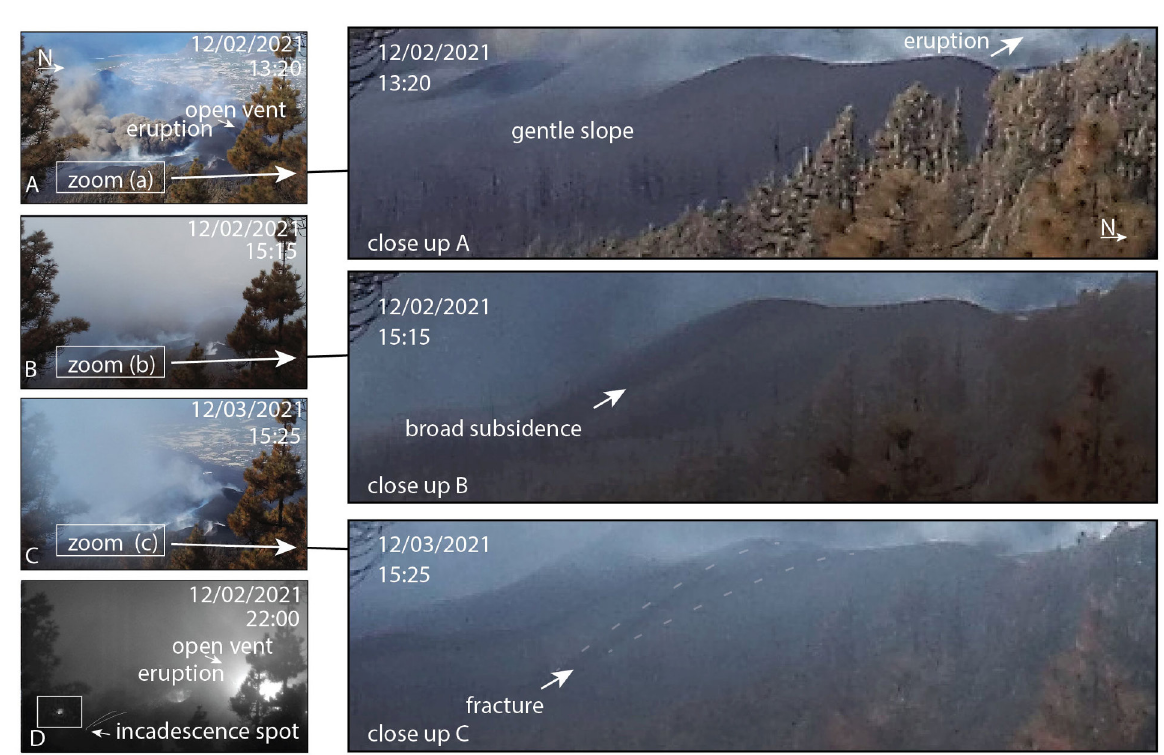
Figure 3: Camera records, realised by fixed installed time-lapse trail Cam-4 (for location, see Cam-4 in Figure 1B). The selected images allow us to determine approximate timing and evolution of the fracture. [A] View onto the eruption crater, also visible is the steaming of the new open vent to the right. Close up shows gentle slope. [B] Limited visibility, but close up (right column) onto the gentle southern slope illustrates the emergence of a broad subsidence region. No fractures are visible yet on 02 December 2021 at 15:15 (UTC). [C] Strongly degassing volcano, close up (right column) shows the presence of knife-sharp fractures on 02 December 2021 at 15:25. [D] Night time image shows incandescent spots on southern part of the fracture. Due to limited visibility, other images for the period were not found